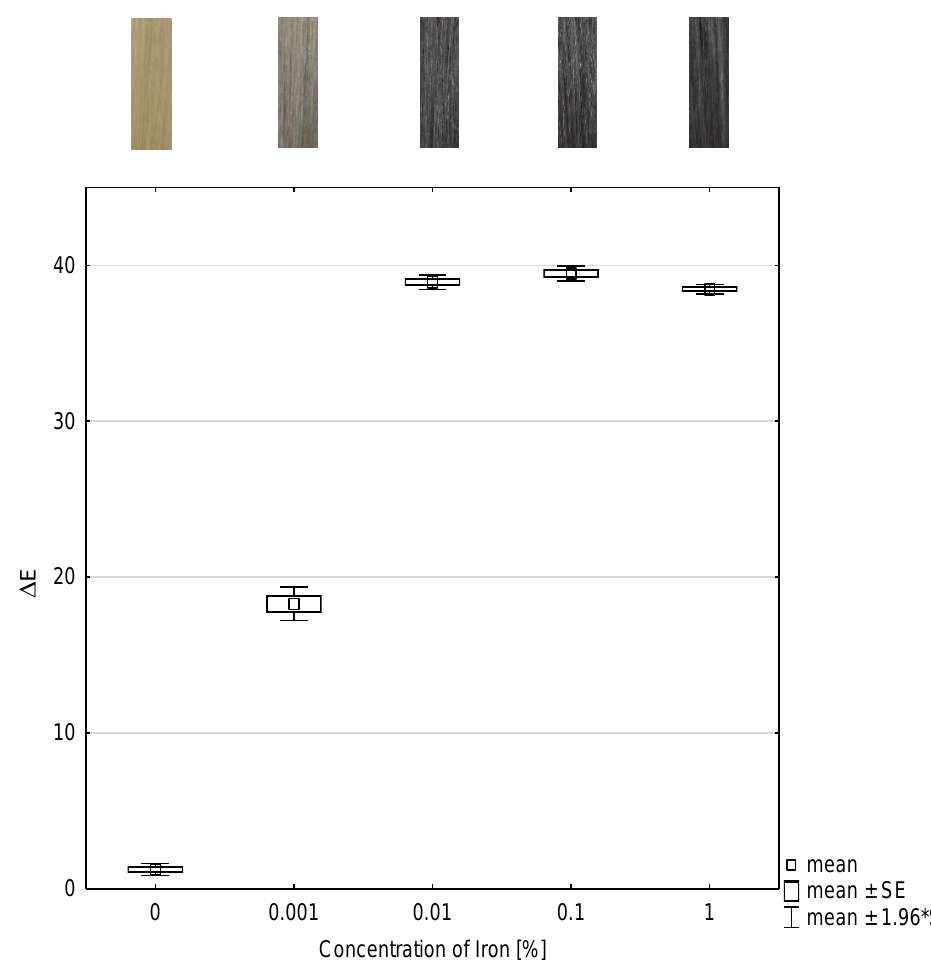
Figure 2. Box and whisker plot of color change ∆ E-value of dyed hair tresses with different concentrations of iron(II)-lactate in combination with 10 wt% matcha and the corresponding photographs of the hair tresses (n = 10). SE: standard error. Table 2. Color coordinates, L, a, b, and ∆ E of hair tresses dyed with different concentrations of